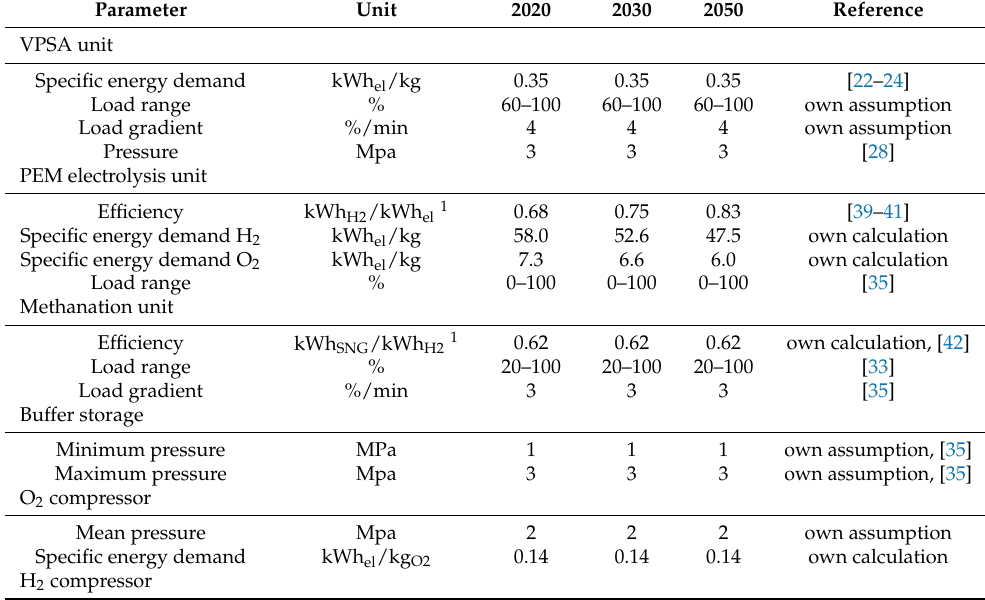
Table 2. Parametrization of the model